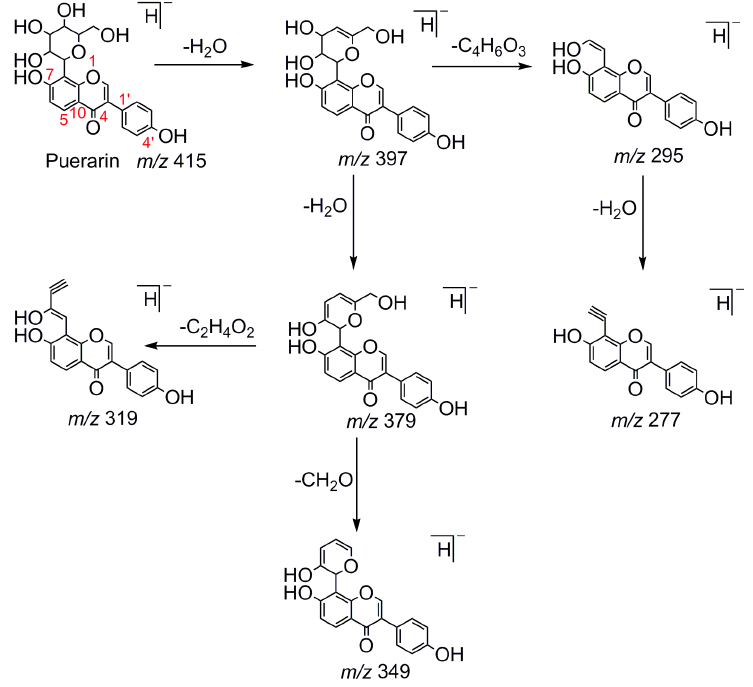
Figure 3. The mass fragmentation behavior of puerarin (Red number is location for compound nomenclature).